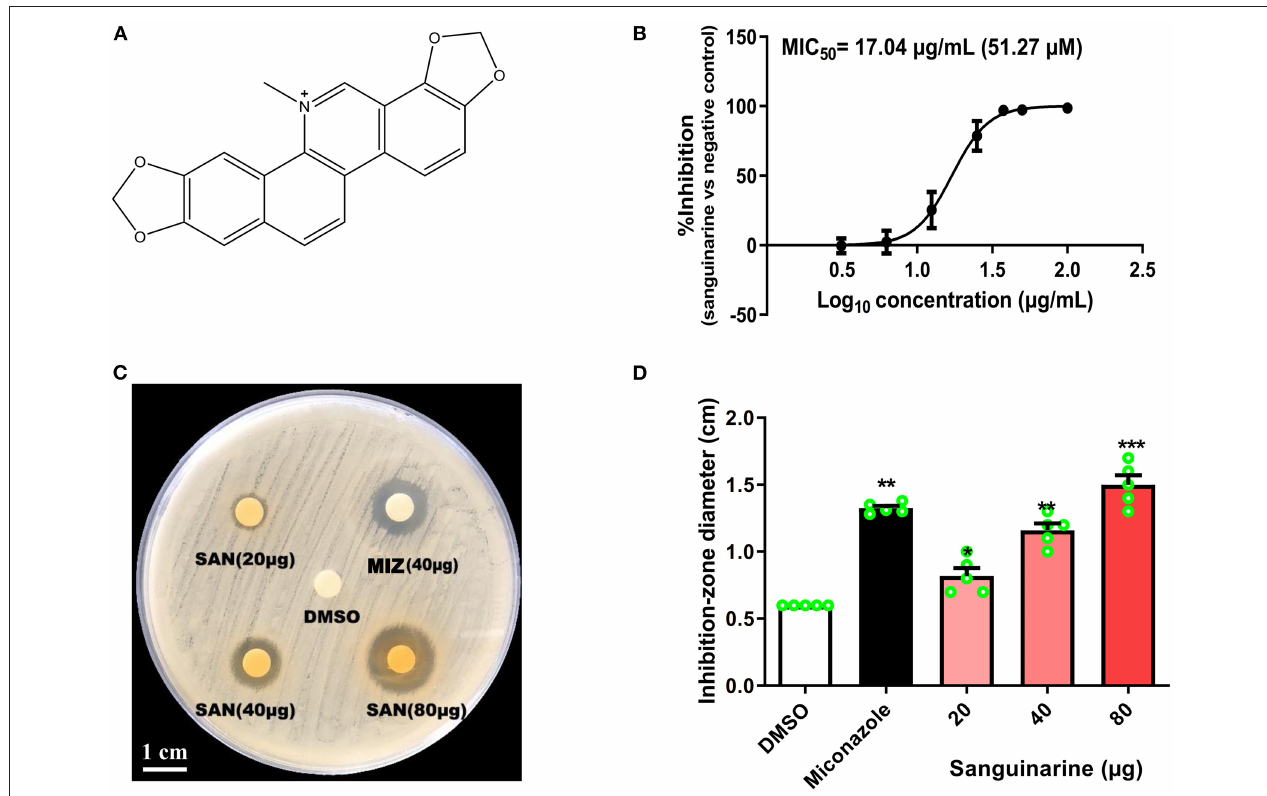
FIGURE 1 | (A) Molecular structure of sanguinarine (SAN). (B) SAN dose–response curve for inhibitory effects against C. albicans (ATCC 10231). A seven-point dose–response relationship was determined for SAN in the antifungal microbroth dilution assay. The data were plotted as percentage of control (100%) at each dose point. The MIC 50 value was determined at 24h incubation. (C) A representative C. albicans petri-dish sample with the zone of inhibition marked. (D) Effects of SAN on the inhibition zone diameter produced against C. albicans. Miconazole (MIZ, 40 µ g) was served as a positive control. Values are expressed as mean ± SD, n = 3. * p < 0.05, ** p < 0.01 and *** p < 0.001 vs. the DMSO control group.